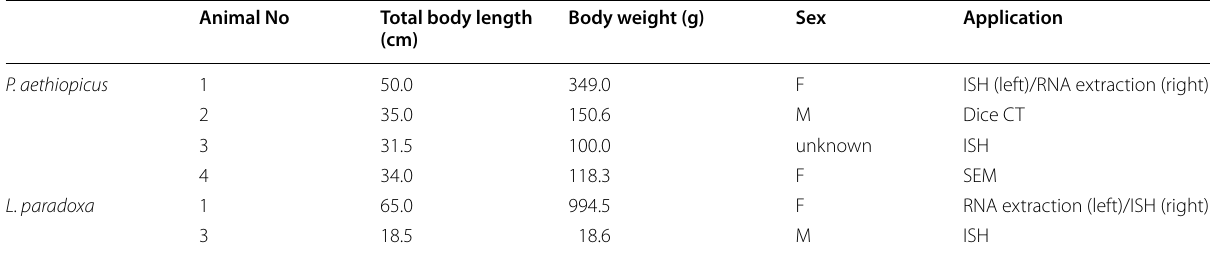
ISH in situ hybridization; Dice CT Diffusible iodine-based contrast-enhanced computed tomography; SEM Scanning Electron Microscopy